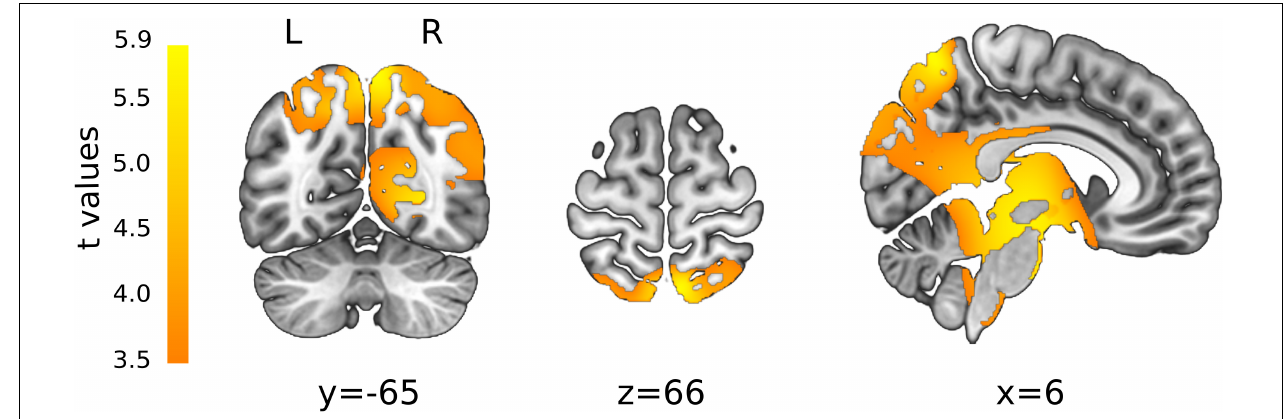
FIGURE 6 | t -maps resulting from statistical comparison between the left- and right-sided stimulation (L > R). All t -values were positive, representing a stronger associated activity for left-sided stimulation. Color gradient from orange to yellow is associated with increasing t -values. L, left; R, right orientation. X, Y, and Z are coordinates in MNI